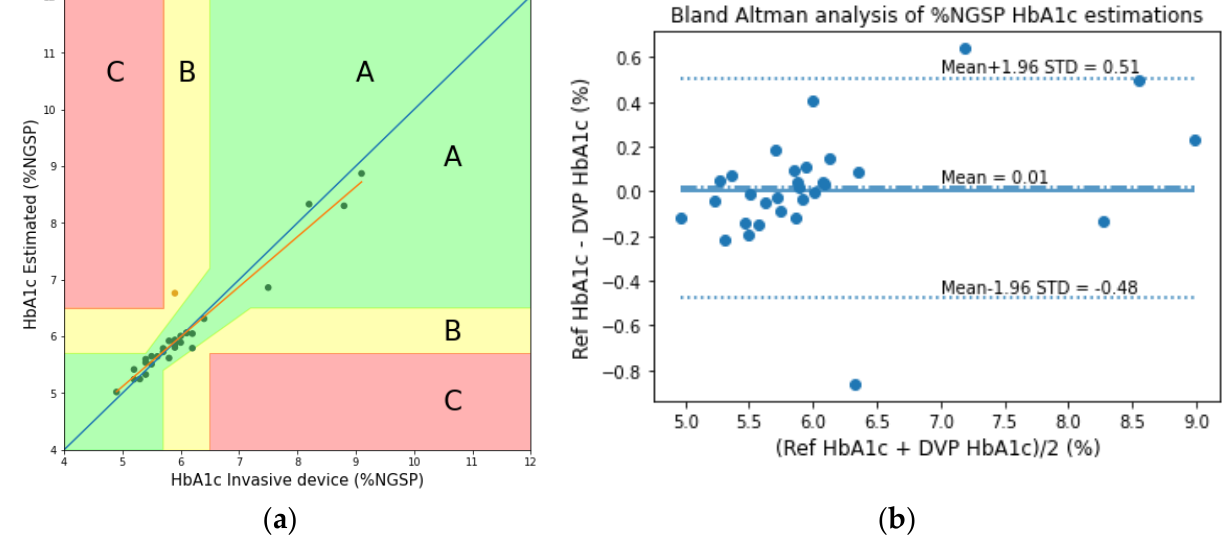
Figure 20. ( a ) EGA and ( b ) the Bland–Altman analysis plots of the experimentally acquired data for